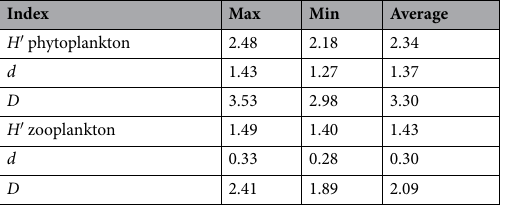
Table 2. Ecological index of phytoplankton and zooplankton community in study water body after 30 days’ EAS